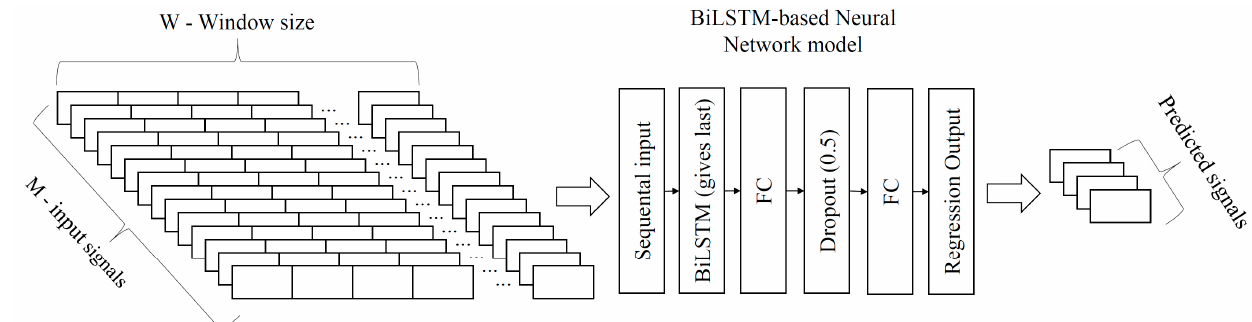
Figure 3. Structure of BiLSTM-based RNN, its inputs and outputs.